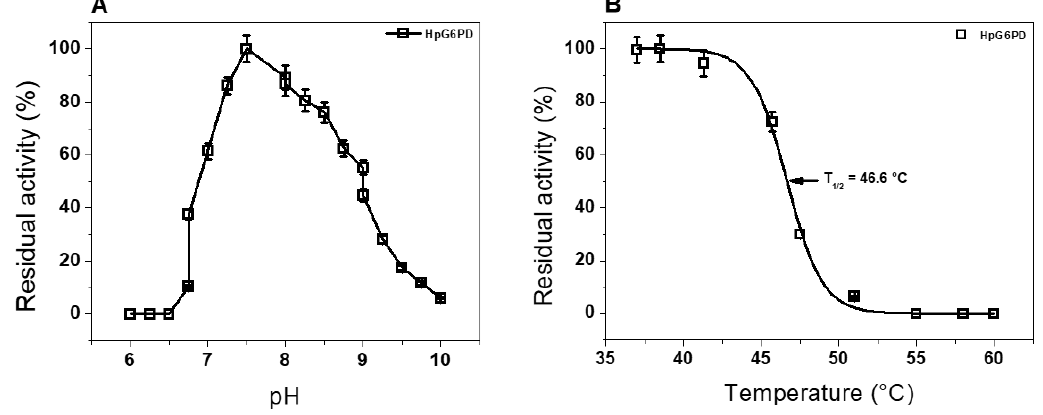
Figure 3. The effect of pH and temperature on the catalytic activity of the HpG6PD protein. ( A ) The effect of pH on the activity of the HpG6PD protein. The enzyme was incubated in four system buffers with a pH ranging from 6.0 to 10.0. The non-enzymatic reduction of NADP + was also measured at each pH value, to subtract the value obtained at each experimental point. ( B ) The effect of temperature on the activity of HpG6PD protein. In both experiments, the protein was adjusted to 0.2 mg/mL, and 1 µ g of total protein was used to measure the residual activity. Data are presented as mean values ± Standard Error Media (SEM) of 3 independent